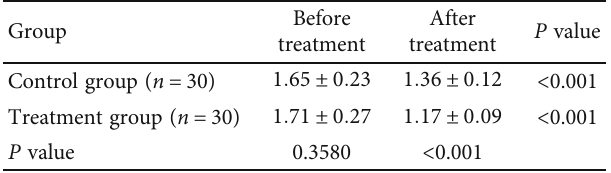
Table 2: Comparison of IMT of CAP between the two groups (mm). Group